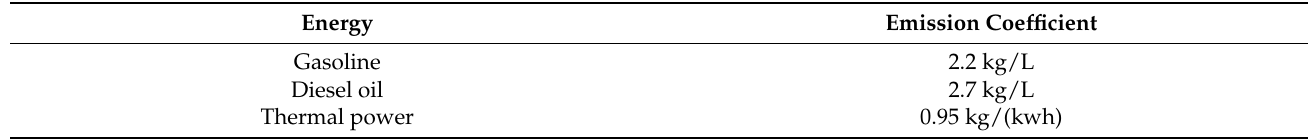
Table A3. Default values of emission factors.